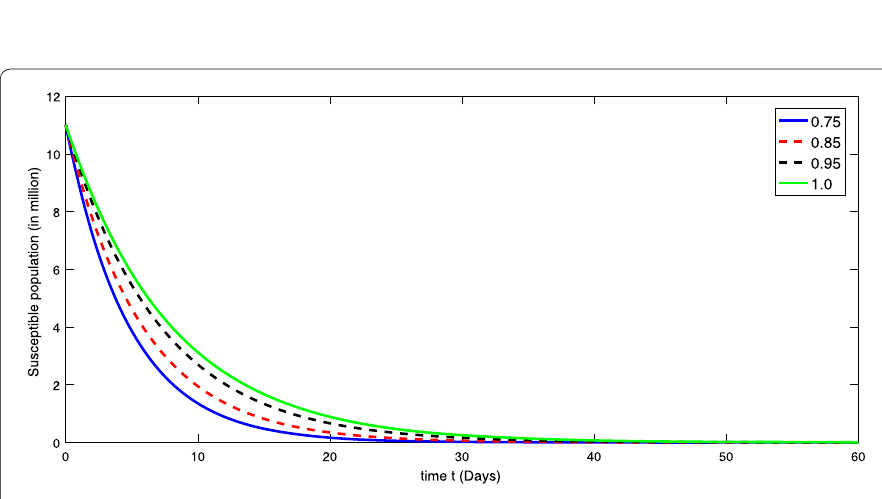
Figure 3 The dynamics of the recovered class at various values of fractional order κ using ABC derivative at the minimum value of immigration